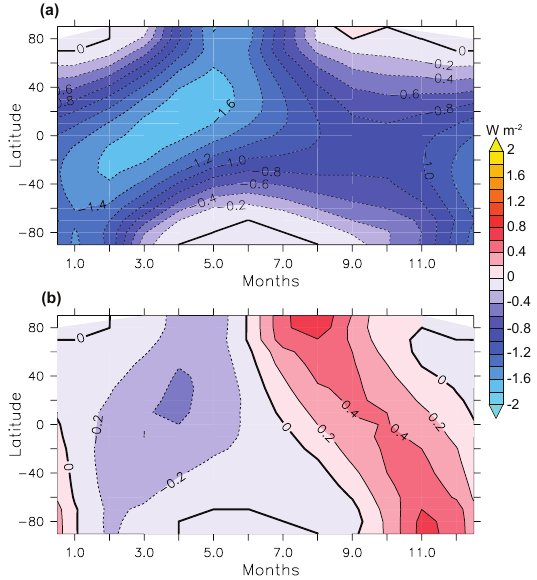
Figure 4. Difference in incoming solar radiation at the top of the atmosphere (Wm − 2 ) between the PMIP4 and PMIP3 proto- cols, (a) considering the changes in Earth’s orbital parameters be- tween 1850 and 1950 and the reduction of the solar constant from 1365 to 1360.7 between these two PMIP phases and (b) only the changes in Earth’s orbital parameters, assuming a solar constant of 1365Wm − 2